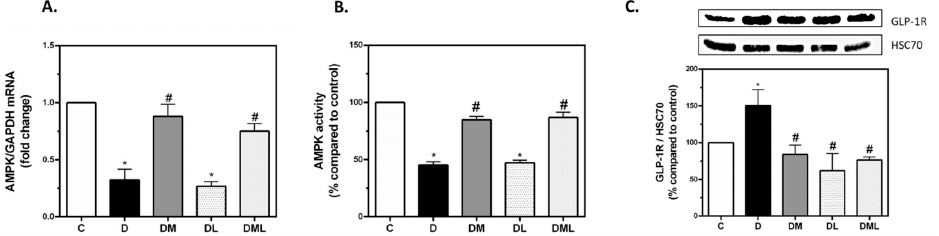
Figure 2. AMPK mRNA levels, AMPK activity assay and GLP-1R protein expression in kidney tissues. ( A ) Bar plot representing the differential expression of AMPK in all rat groups normalized against GAPDH expression. ( B ) Bar plot representing the differential AMPK activity in all rat groups. ( C ) Representative immunoblot of GLP-1R protein (up), and bar plot reflecting the quantification of GLP-1R protein expression (below) against HSC70. AMPK: adenosine monophosphate kinase, GAPDH: glyceraldehyde 3-phosphate dehydrogenase, GLP-1R: glucagon-like peptide-1 receptor, HSC70: heat shock cognate. All data are expressed as mean ± SEM. * p ≤ 0.05 diabetic vs. control groups. # p ≤ 0.05 treated vs. diabetic groups.